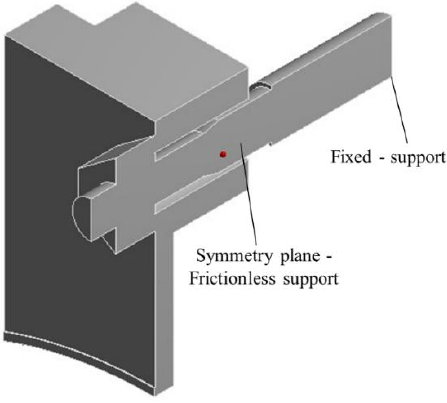
Figure 4. The simplified model of the bolt and the limit stop.